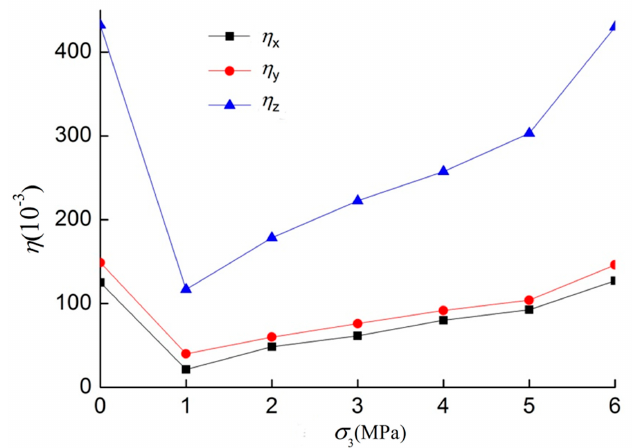
Figure 5. The curve of the airwave velocity attenuation (WVA) rate and confining pressure.